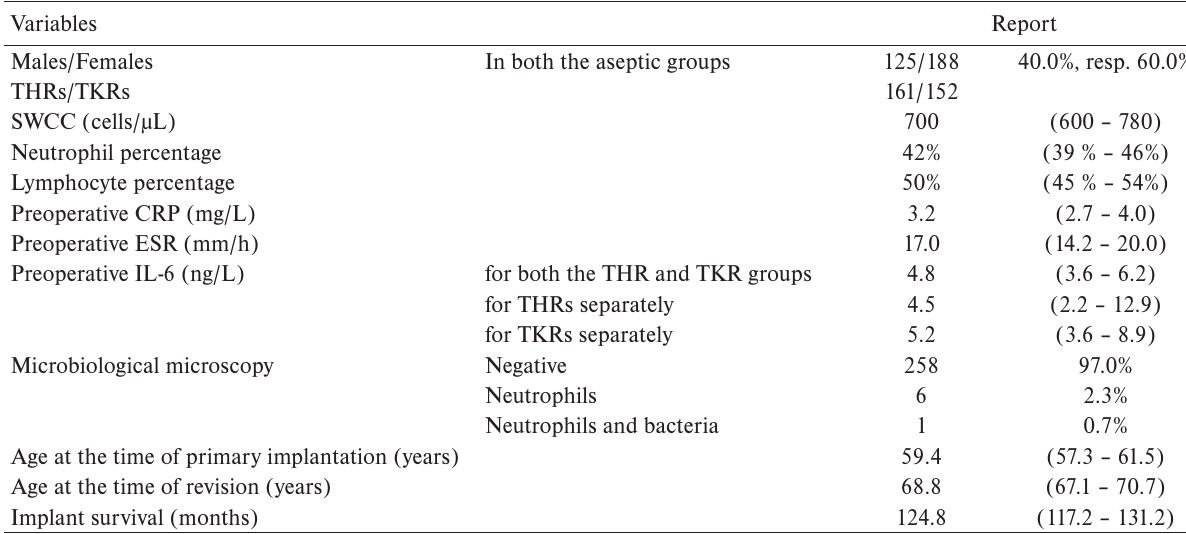
Table 2. List of variables describing the control